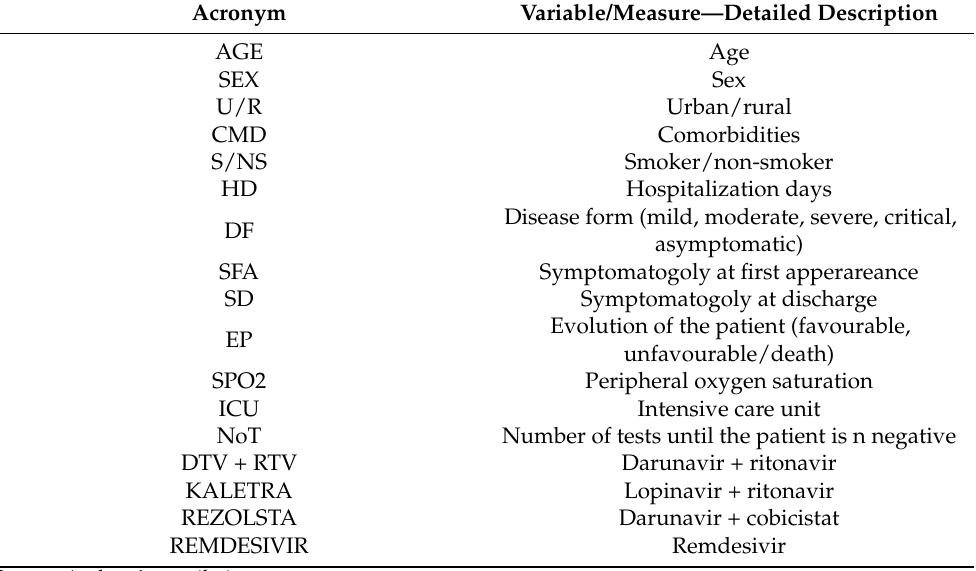
Table A1. Detailed description of the variables (specific measurements) used in the empirical analysis.